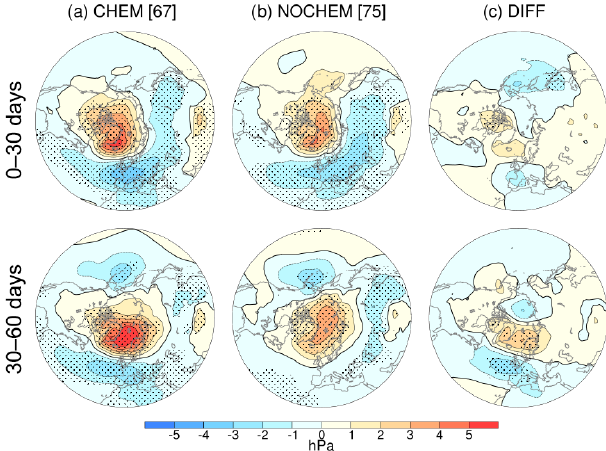
Figure 3. Composites of sea level pressure (SLP) anomalies (in hPa) in the 0–30 and 30–60d following the central date of DJF SSWs in CHEM (WACCM; a ) and NOCHEM (SC-WACCM; b ) simulations, as well as the difference in the CHEM and NOCHEM composites (c) . Significance at the 95% level using a Monte Carlo test (a, b) or a two-sided t test (c) is indicated by stippling. The number of events included in each composite is noted in brackets above the